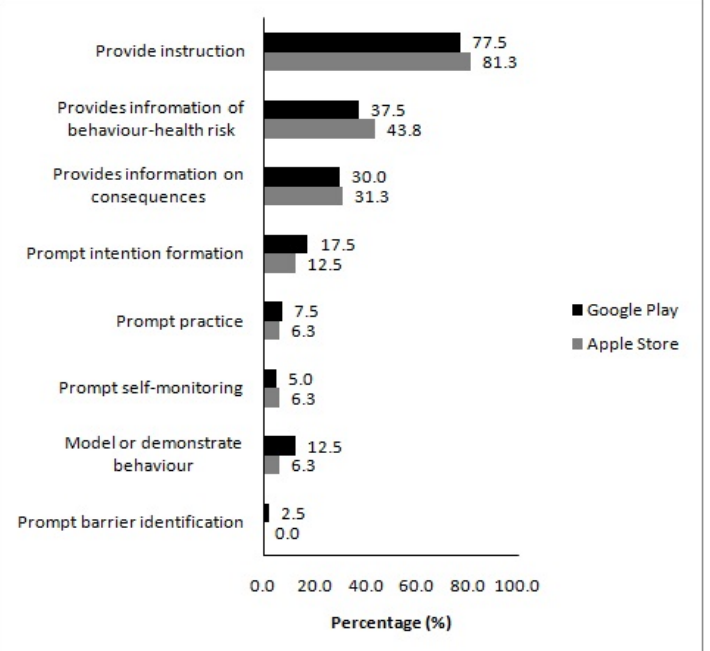
Figure 3. Presence of individual behaviour change techniques in the analysed apps, according to platform. Values on the x -axis denote the proportion of apps a behaviour change technique was present in.